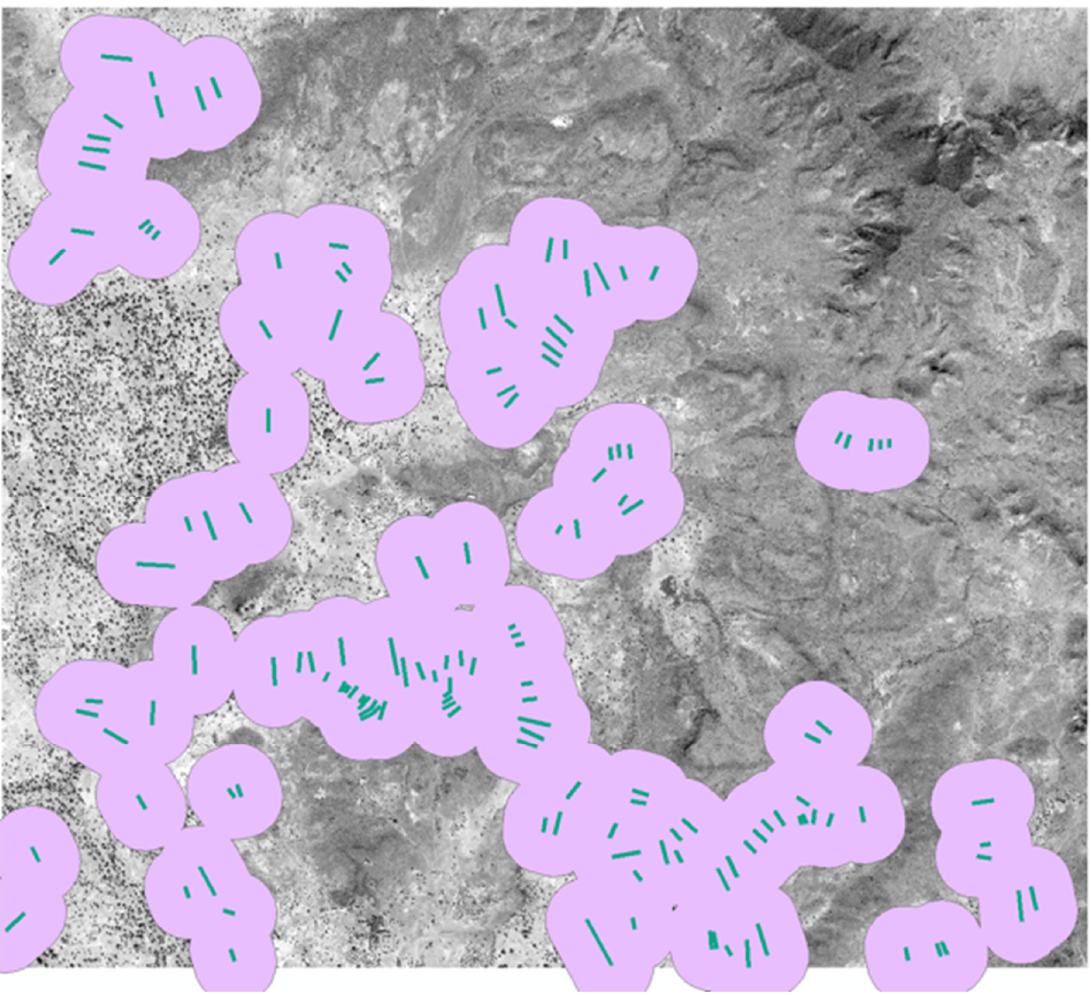
Figure 7. Digitized semi-permeable dams and 200-m buffers – Sakou.